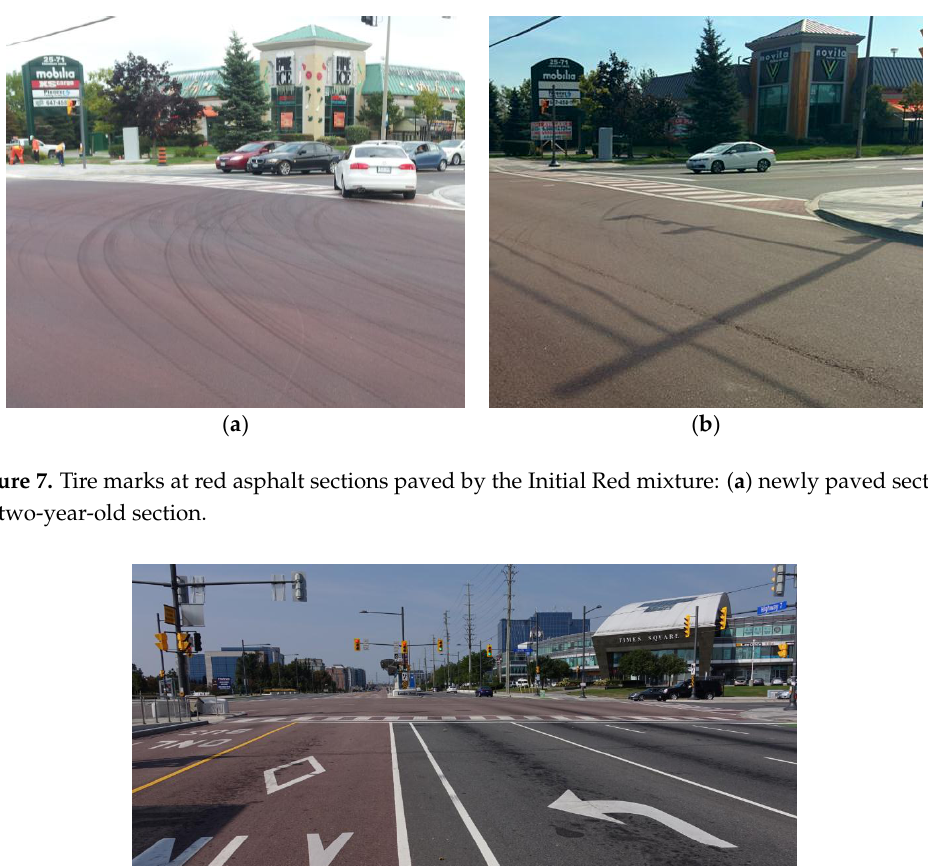
Figure 7. Tire marks at red asphalt sections paved by the Initial Red mixture: ( a ) newly paved section; ( b ) two-year-old section.